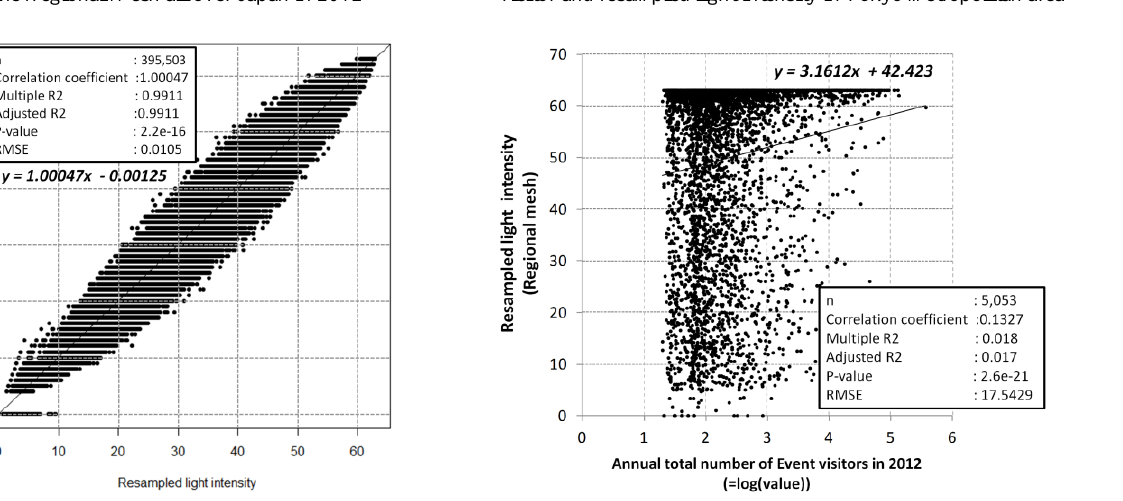
Figure 7. Comparison of resampled light intensities with original light intensities at centroid of each Regional Mesh